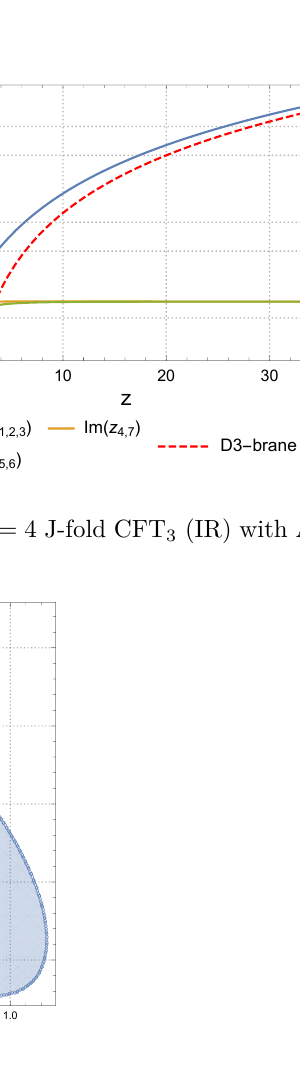
Figure 9 . Section of the parameter space with λ 1 = 0 showing the region accommodating regular holographic RG flows involving the N = 4 J-fold CFT are equivalent due to the exchangeability of the parameters λ